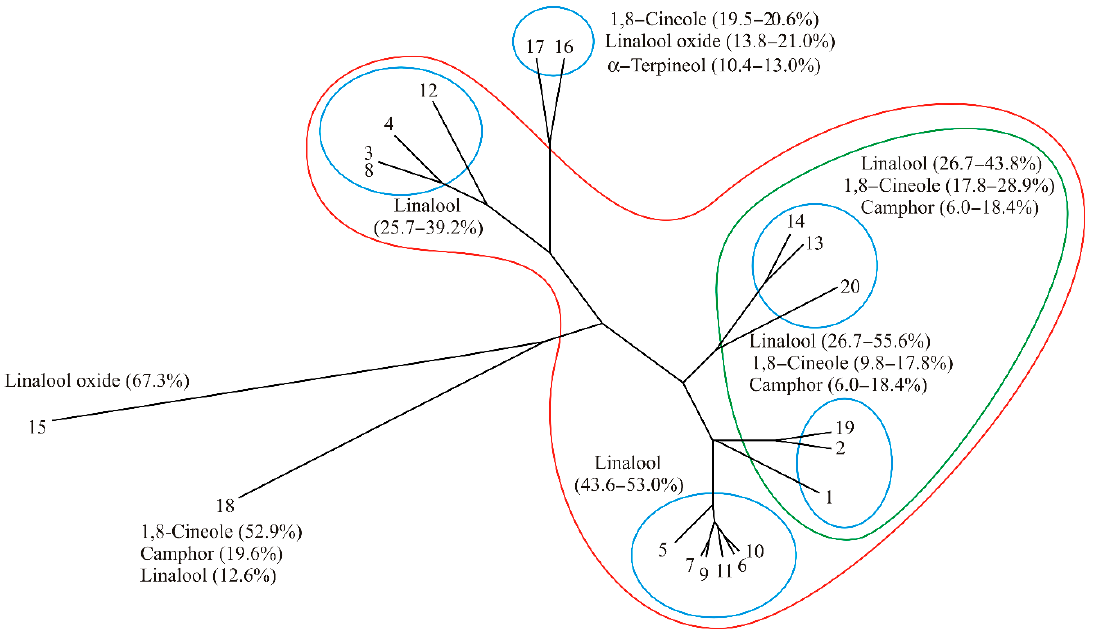
Figure 6. Unrooted cluster tree for chemical composition of L. x intermedia hydrolate according to literature and this study (samples are coded according to Table 7).